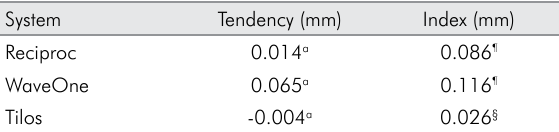
Table 2. mean values of the tendency of transportation and transportation index.